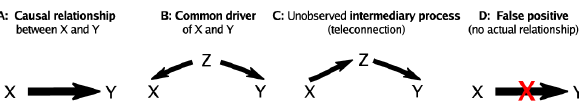
Fig. 2. Significant similarities between the time series at two loca- tions, X and Y, can arise from (a) direct physical coupling, (b) a teleconnection, (c) a common driving mechanism or (d) by chance as false